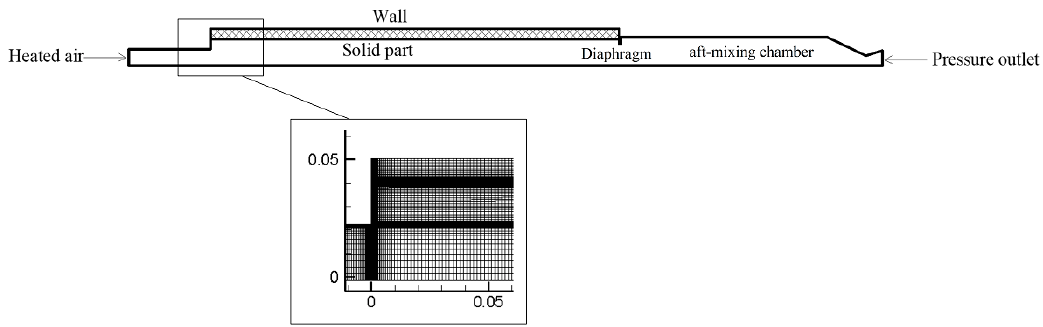
Figure 8. Physical model of simulation.